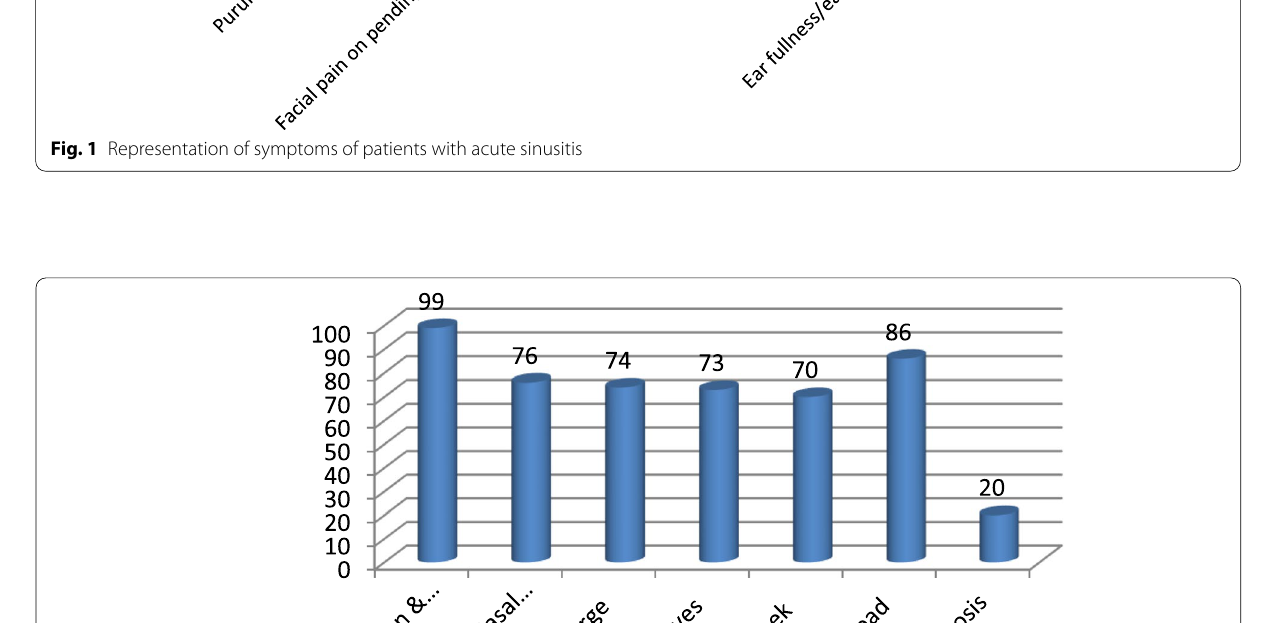
Fig. 1 Representation of symptoms of patients with acute sinusitis